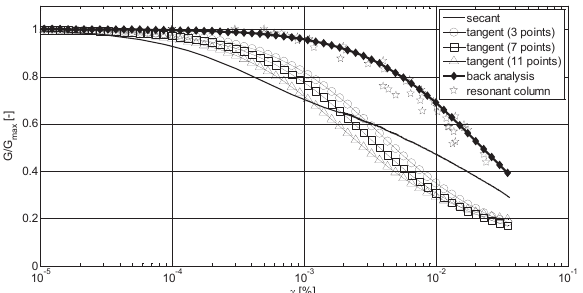
Figure 14: The results of RC/TS analyses of the sample S5919. Fig. 14. The results of RC/TS analyses of the sample S5919.